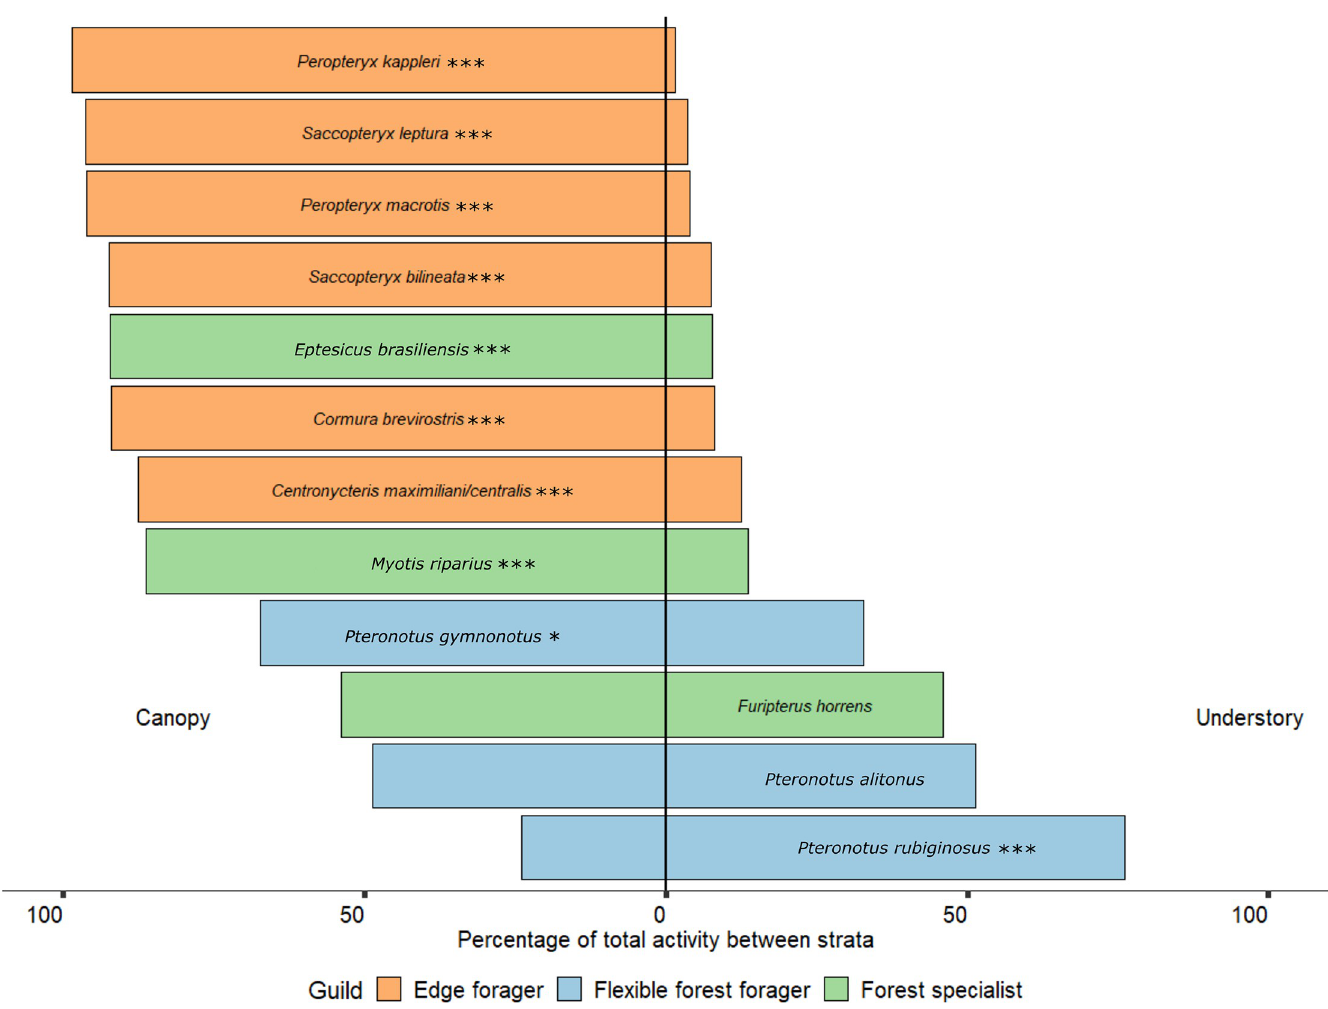
Fig 4. Vertical stratification of twelve Amazonian bat species. Comparison of total bat activity (bat passes) per species/sonotype recorded in the understory and canopy at the Biological Dynamics of Forest Fragments Project. Significance values � < 0.05, ��� < 0.001.